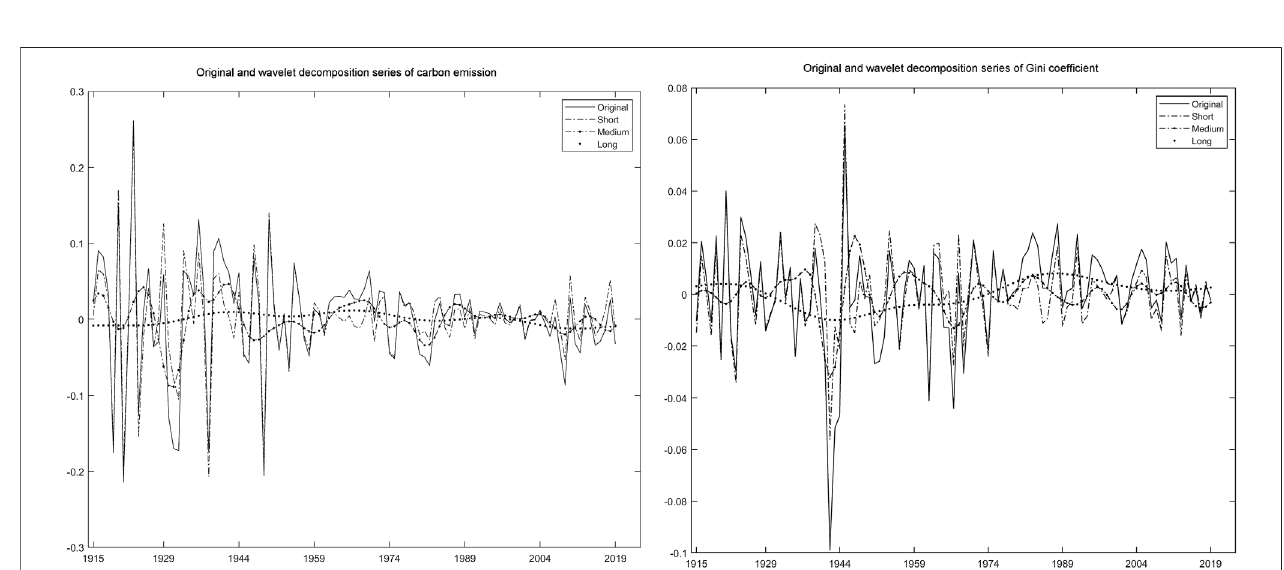
FIGURE 2 | Original and wavelet decomposition series of carbon emission and Gini coef fi cient for the U.S.